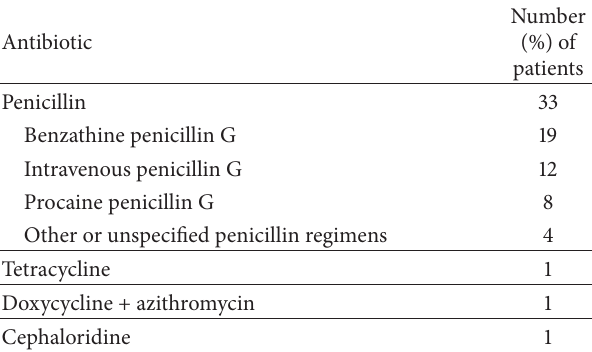
Table 1: Antibiotic treatment of 36 cases of secondary syphilis with bone involvement